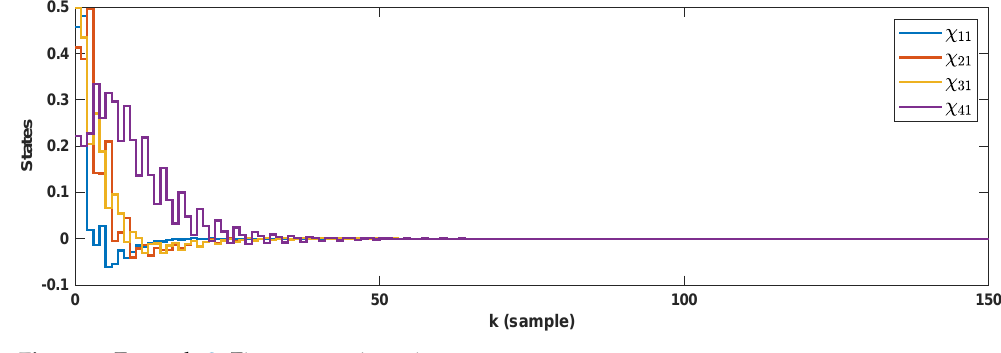
Figure 8. Example 2: First state